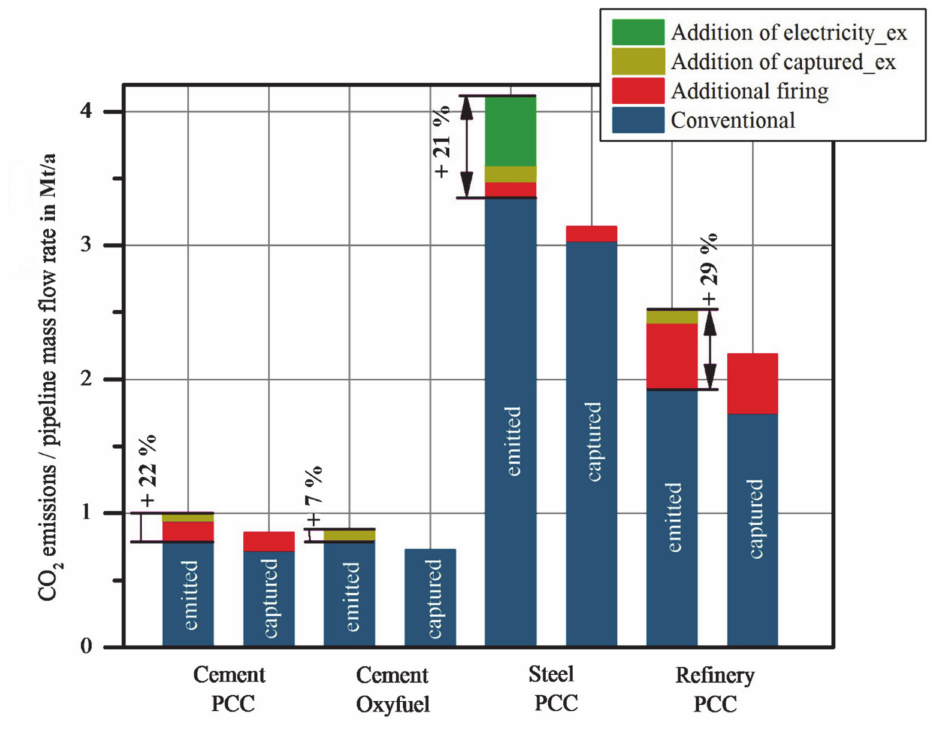
Figure 3. CO 2 emissions and resulting pipeline mass flow rates of industrial plants with additional CO 2 emissions due to CO 2